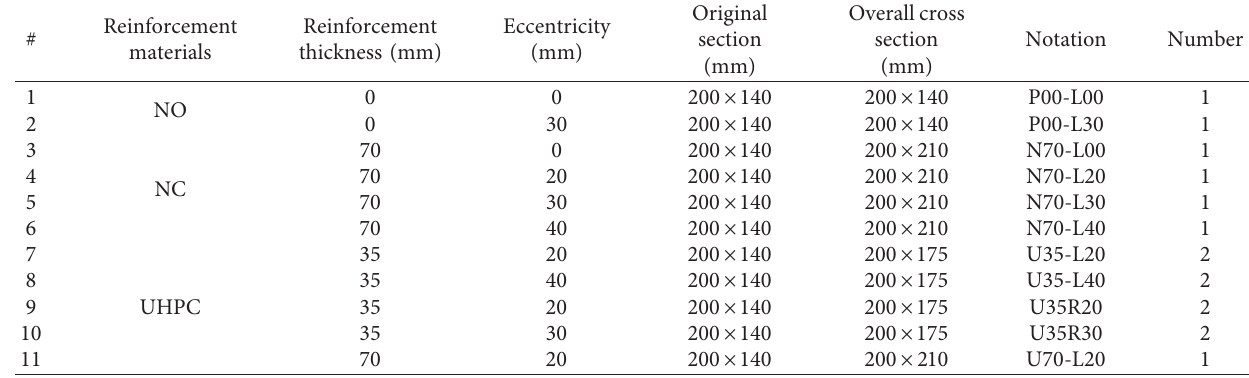
Table 1: Details of segment models.